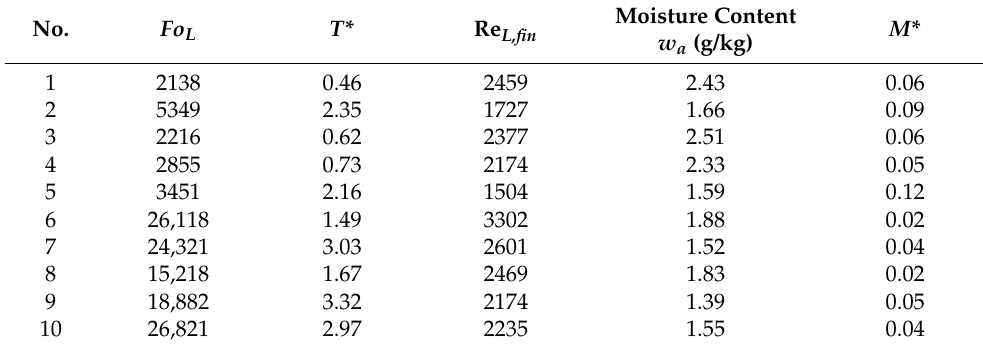
Table 8. Parameter values under different operating conditions on evaporation